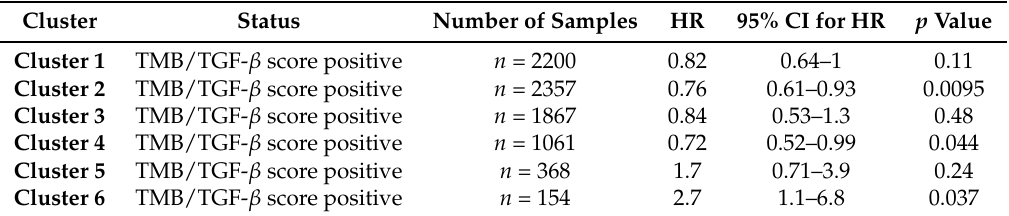
Table 3. Univariate Cox regression analysis of OS on the six immune subtype clusters described in Thorsson et al. [17]